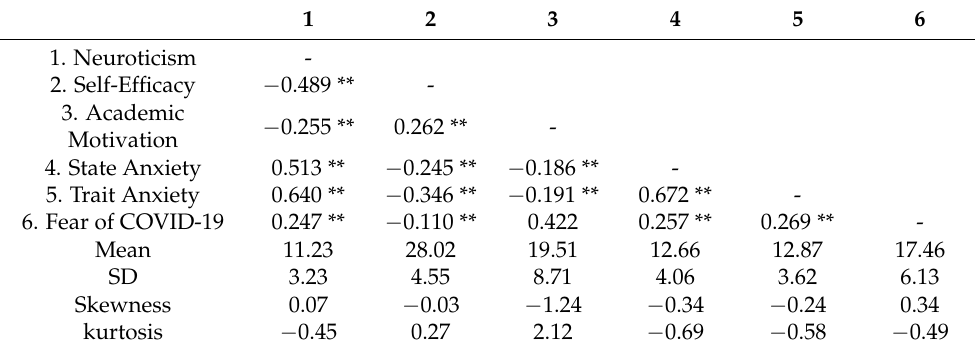
Table 1. Means scores, standard deviations, skewness, kurtosis, and Pearson’s bivariate correlations for study observed